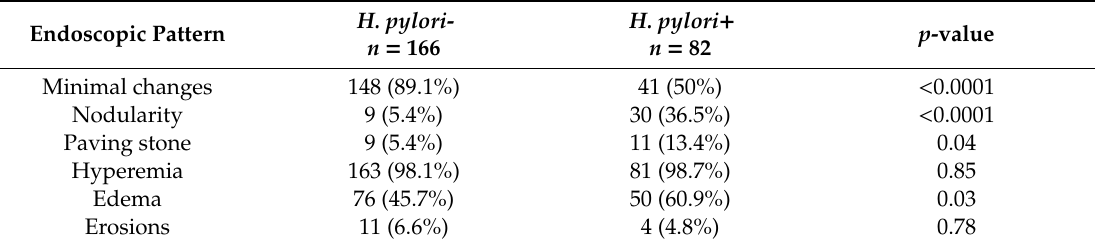
Table 4. Endoscopic pattern of the gastric mucosa in children with or without H. pylori infection. Endoscopic